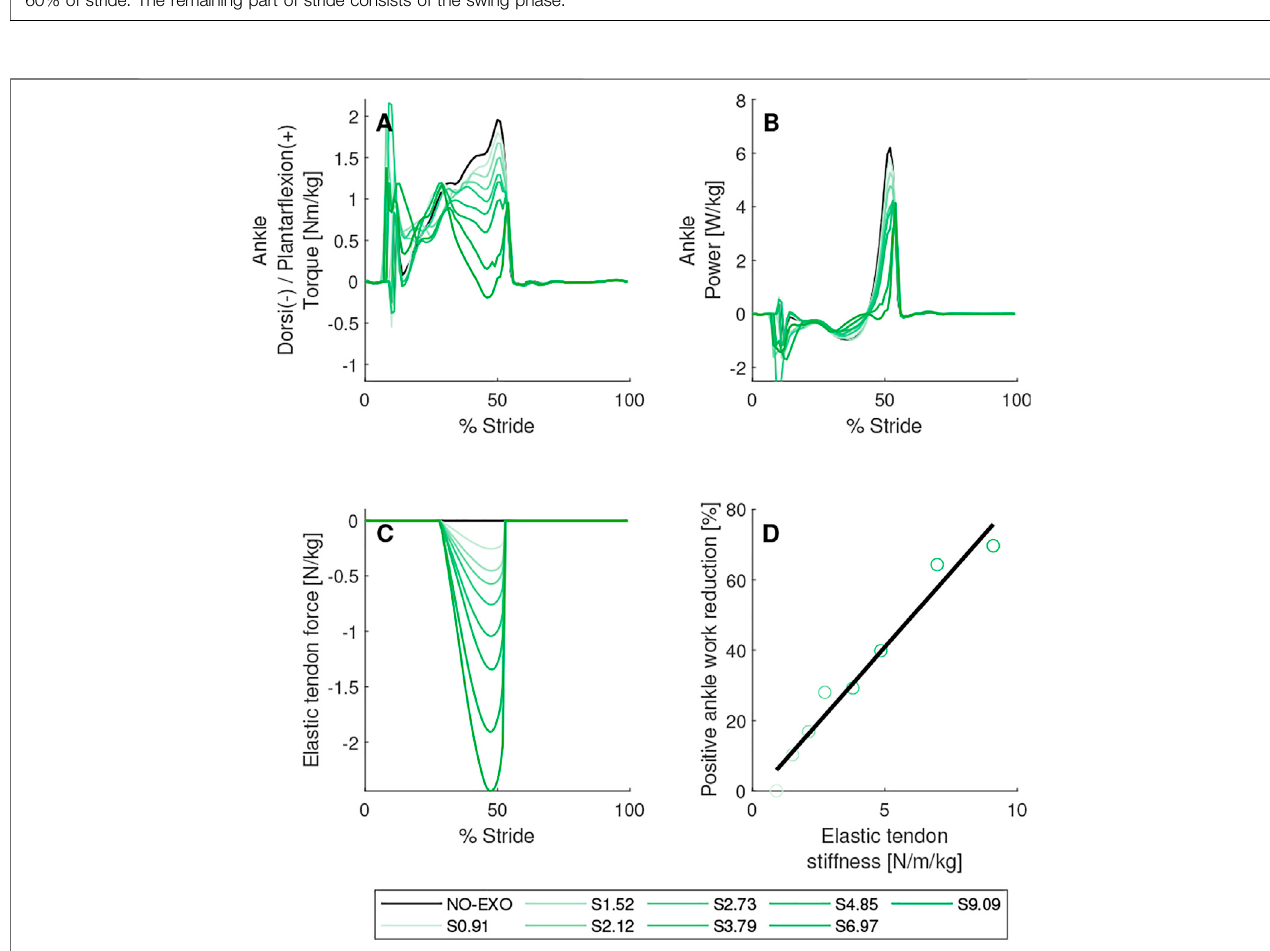
FIGURE 6 | Elastic tendon stiffness parameter sweep. Biological torques (A) and powers (B) are shown for the right leg on which AN-EXTRA-Push is worn. In (C) , forceintheelastictendonisshown.In (D) ,linearregressionbetweenelastictendonstiffnessvalueandpositiveankleworkreductionisshown.Brakeengagementtiming was set to 29% of stride and brake disengagement timing was set to 53% of stride. Conditions are abbreviated and color coded as follows: without exoskeleton (NO- EXO) (black) and active exoskeleton assistance with elastic tendon stiffness values of {0.91, 1.52 2.12, 2.73, 3.79, 4.85, 6.97, 9.09} N/m/kg (S0.91, S1.52 S2.12, S2.73, S3.79, S4.85, S6.97, S9.09) (green; from light to dark in the same order).